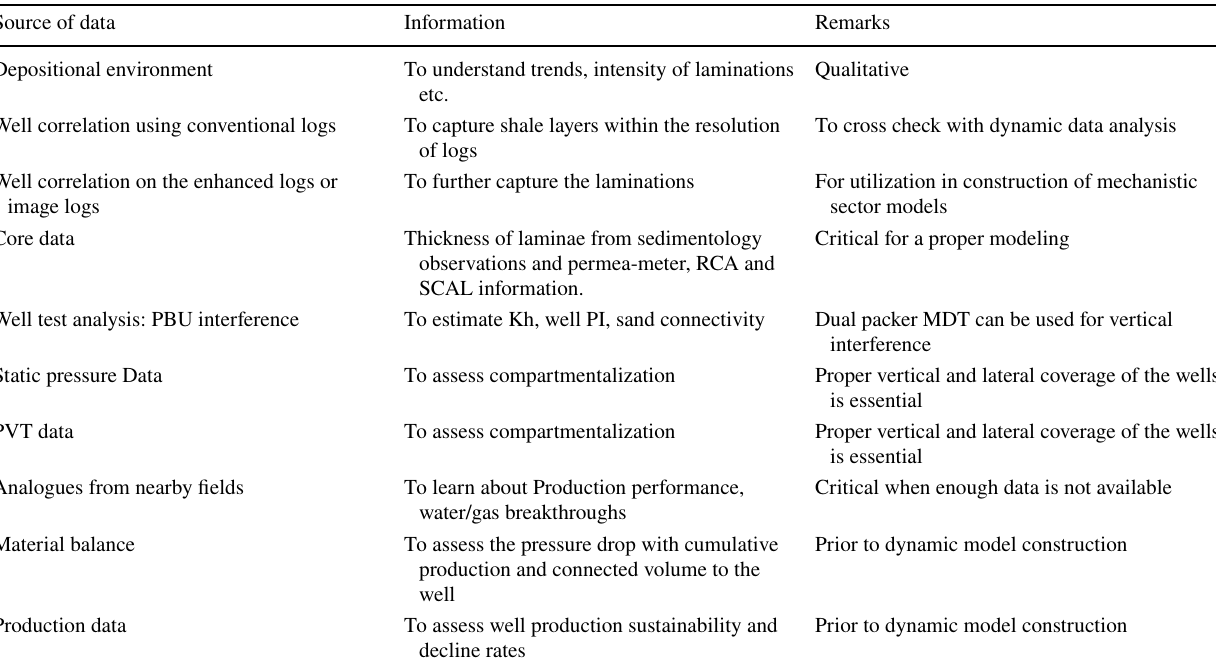
Table 2 Estimating the sand connectivity through use of static and dynamic data Source of data